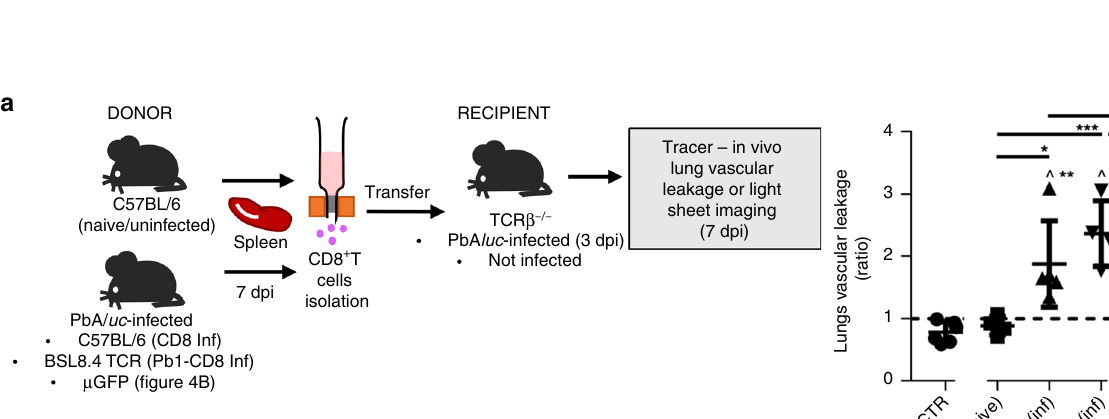
Fig. 4 Anti-CD8 β protects PbA luc -infected mice from pulmonary vascular leakage. Comparison between PbA luc -infected mice (CTR) and PbA luc -infected mice depleted of CD8 + T cells ( α CD8 β ) at 6 dpi. a Peripheral parasitemia of CTR (given rat IgG1 isotype control) ( n = 9) and α CD8 β ( n = 12) mice at 7 dpi. b Ratio of in vivo lung vascular leakage measured by Tracer-653 dye and c ex vivo quanti fi cation of parasite biomass in perfused lungs based on the luciferase activity of the PbA luc parasite in CTR ( n = 9) and α CD8 β ( n = 12) mice at 7 dpi. The data shown was pooled from two independent experiments. d H&E staining of histologic lung sections. Black arrowhead = intra-alveolar edema; black arrow = intra-alveolar erythrocyte extravasation; blue arrow = thickened alveolar septa; and yellow arrowheads = intra-alveolar macrophages/monocytes. Pathological changes were graded on a scale of 1 to 5 (0 = no abnormalities; 5 = severe): e overall lung pathology score; f total edema and g severity of intra-alveolar erythrocyte extravasation in non-infected/naïve ( n = 3), PbA luc -infected CTR ( n = 5) and α CD8 β ( n = 6) mice. Naïve mice were not depicted in the graphs as they obtained a pathological score of zero. The black dashed line at y = 1 in ( b ) represents the ratio of the tracer reading from naïve C57BL/6 mice ( n = 3). For ex vivo quanti fi cation of parasite biomass in the lungs, data are expressed on a log scale, with naïve C57BL/6 mice indicated by the black dashed line in ( c ). h Immuno fl uorescence of FFPE lung sections of naive, PbA-infected and PbA-infected plus α CD8 β -treated mice at 7 dpi, stained with ZO-1 and E-cadherin antibodies. Images are representative of two mice per group. i Quanti fi cation of the average pixel intensity of ZO-1 drawn over the apical ZO-1 signal (blue box in ( h )). Scale bar = 20 mm. The quanti fi cation shown is representative of three independent experiments. The data represent the means ± SD; * p < 0.05, ** p < 0.01, **** p < 0.0001, by Mann – Whitney test ( a – c ), unpaired student ’ s t test ( e – g ) or by ANOVA with Bonferroni ’ s post-test ( h – i )